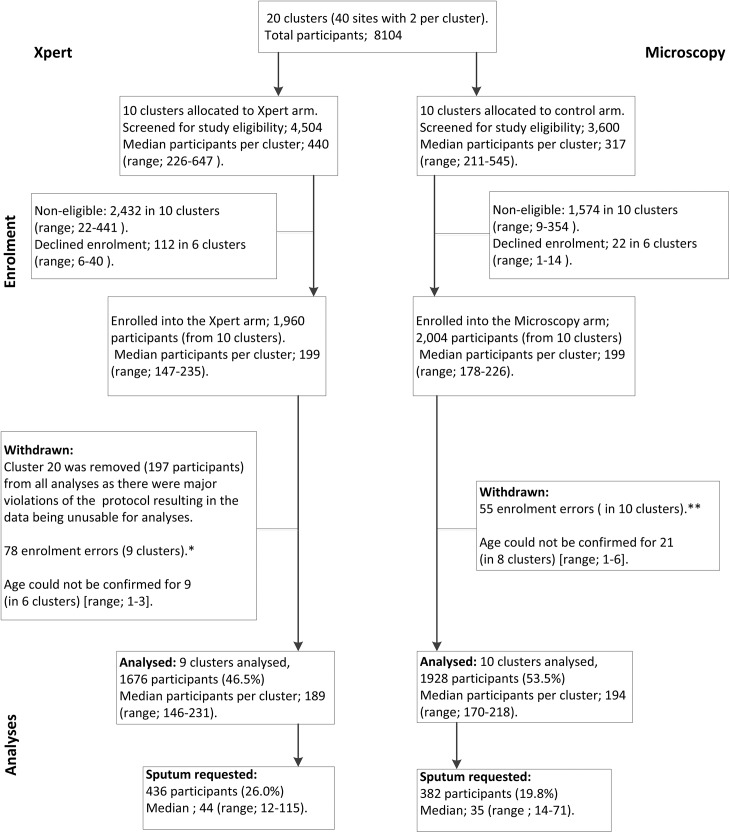
Participant flow for the exit interview substudy.Legend: *Participant enrolment errors, Xpert arm: did not complete survey n = 2; underage n = 10; attending clinic for TB care n = 66. **Participant enrolment errors, Microscopy arm: did not complete survey n = 2; underage n = 4; attending clinic for TB care n = 49.